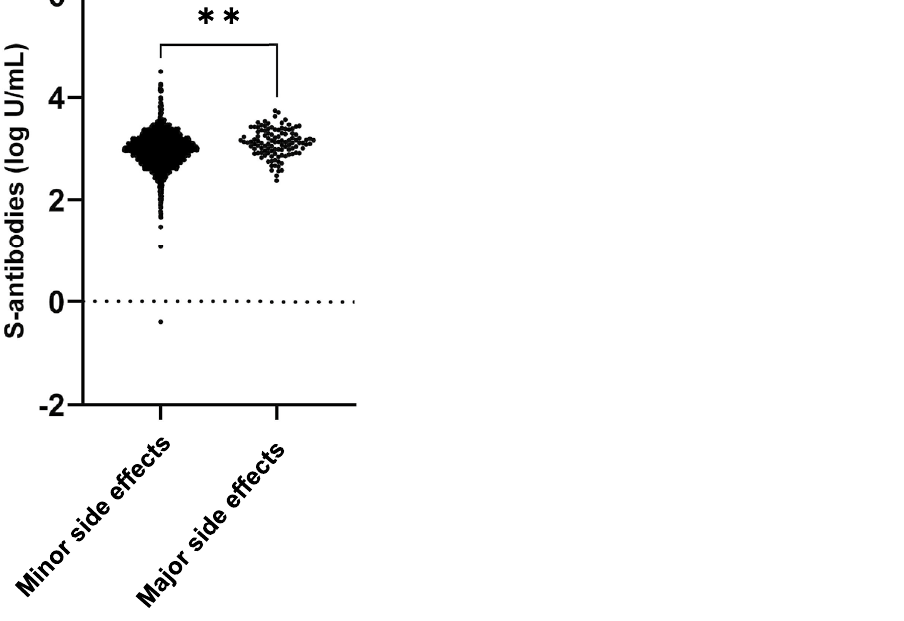
Figure 5. Distribution of total S-specific antibodies in participants after second depending on the side effects severity. Total S-specific antibody levels were quantified. Statistical analysis was performed with student t testing between minor side effects group (n = 2014) and major sides effect group (n = 112). **p value <